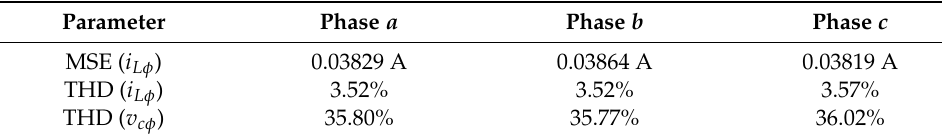
Figure 3. Simulation results for phase a in steady-state condition. Table 3. Simulation results in steady-state condition.